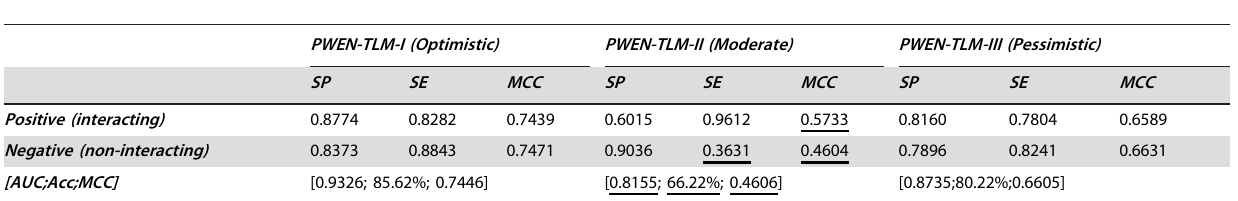
Table 1. Cross validation performance estimation on dataset S1 .